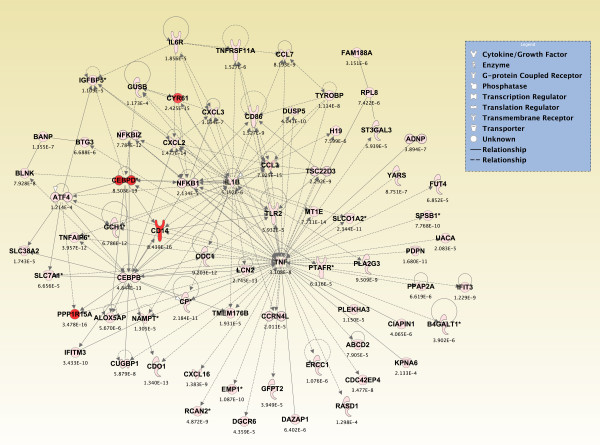
Seizure-induced alteration of inflammatory response, cellular movement, and hematological system development and function gene network. The dataset was filtered on brain region (amygdala, hippocampus, piriform cortex, septum, or thalamus), and a two-way interaction ANOVA was used to identify the genes most significantly altered in each region based on exposure (saline or sarin) and time after seizure onset. The significant genes from each ANOVA (p-value ≤ 0.05) were compared using a Venn diagram, and the top 800 overlapping genes that mapped to canonical pathways in the IPA Knowledge Base were overlaid onto a global molecular network developed from information within the IPA Knowledge Base. The networks were then algorithmically generated based on their connectivity. Genes are represented as nodes of various shapes to represent the functional class of the gene product, and the biological relationship between two nodes is represented as a line. The intensity of the node color indicates the degree of differential expression.